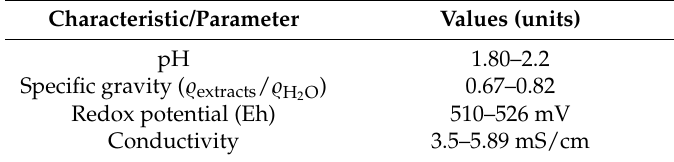
Table 1. Physico–chemical characteristics of the Nepenthes mirabilis digestive